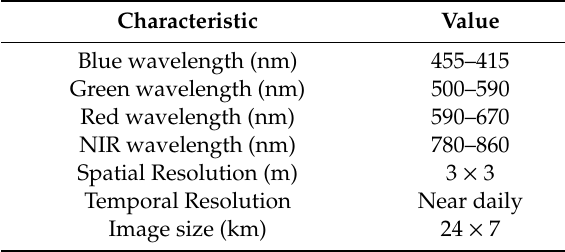
Table 1. Summary of PlanetScope sensor